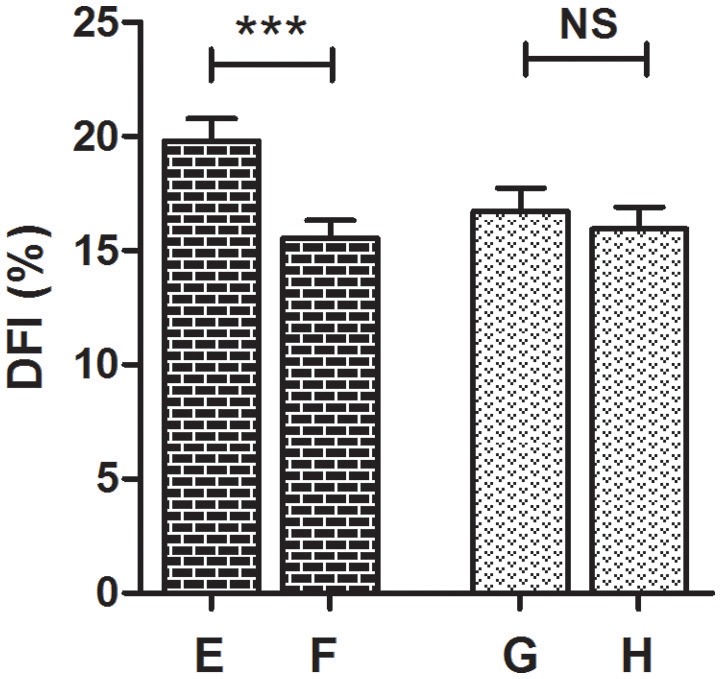
Comparison of the baseline and the post-treatment DFI mean values in smokers (34 patients) and non-smokers (69 patients) (Wilcoxon signed-rank test). (A) Baseline, non-smokers, (B) post treatment, non-smokers, (C) baseline, smokers, (D) post treatment, smokers. ***P < 0.001, NS, not significant.